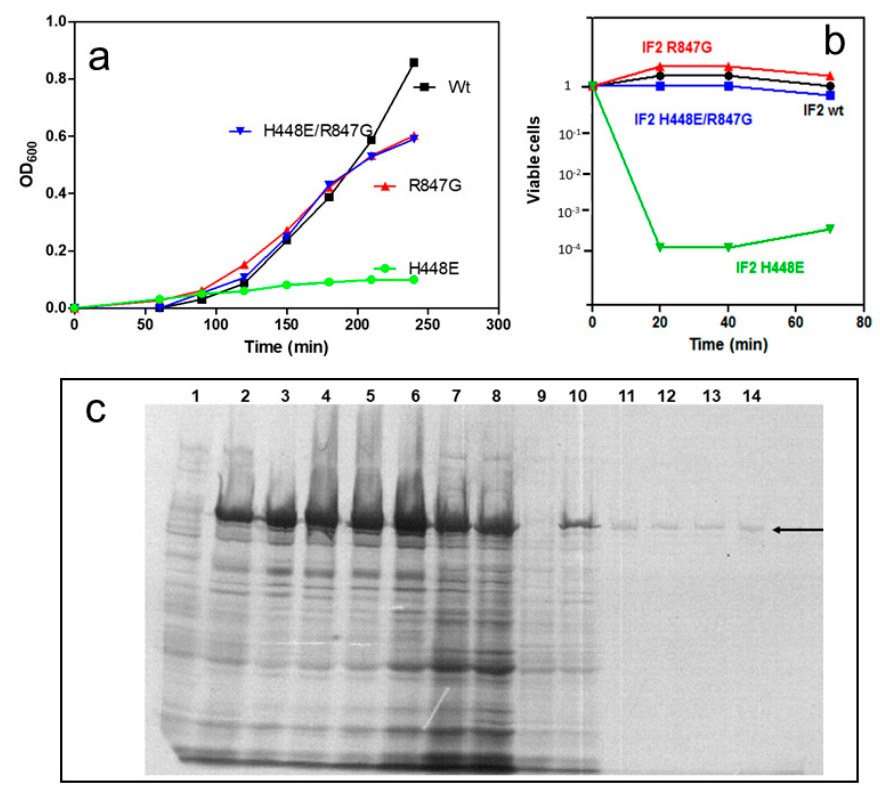
Figure 2. Dominant lethal phenotype of IF2 H448E and lethality suppression by R847G substitution. ( a ) E. coli cell cultures were grown to OD 600 ∼ 0.5 and induced (time 0) by addition of 1 mM IPTG to produce IF2 wt (black), IF2 R847G (red), IF2 H448E/R847G (blue) and IF2 H448E (green). After induction, the growth was followed by measuring the OD 600 at the times indicated in the abscissa. The initial optical densities of the various cultures at the time of induction (approximately OD 600 = 0.5) were normalized and indicated = 0; ( b ) at the indicated times after induction, samples were withdrawn for quantification of viable cells. The numbers of viable cells before induction (time = 0) were normalized and indicated = 1; ( c ) in vivo protein pulse–chase labeling with [ 35 S]methionine. The cultures of E. coli UT5600 cells growing at 30 °C and carrying plasmid pXP101 ( infB wt) (lanes 1–8) or pXP101 infB H448 (lines 9–14) were given 3 min pulses of [ 35 S]methionine followed by a chase with excess non-radioactive methionine before (lanes 1 and 9) and after in- creasing the temperature to 42 °C to induce IF2 expression (lanes 2, 3, 4, 5, 6, 10, 11, 12, 13, and 14). After 15 min at 42 °C, the temperature of the culture was lowered to 37 °C. The pulses were given at: − 4 ′ –0 ′ before induction (lanes 1, 9); 0 ′ –4 ′ (lanes 2,10); 3 ′ –6 ′ (lanes 3,11); 5 ′ –8 ′ (lanes 4,12); 7 ′ –10 ′ (lanes 5,13); 11 ′ –14 ′ (lanes 6,14) after thermal induction; 5 ′ –8 ′ (lane 7); 15 ′ –18 ′ (lane 8) after lowering the temperature to 37 °C. The samples were processed and subjected to electrophoresis, as de- scribed in Materials and Methods. The arrow indicates the position where IF2 migrates, as deter- mined by subjecting to electrophoresis a sample of purified non-radioactive factor loaded on a lane which was not autographed.